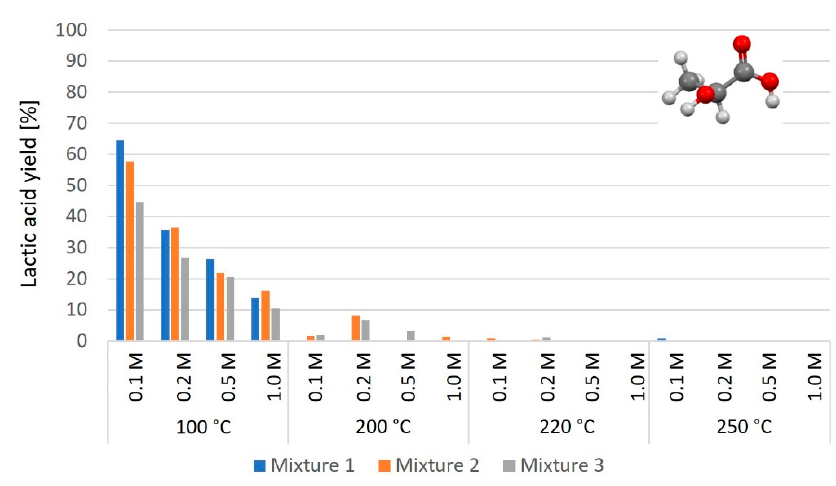
Figure 4. Lactic acid yield as a function of catalyst concentration, temperature, and mixtures of hemicellulosic raw material—1 h process.